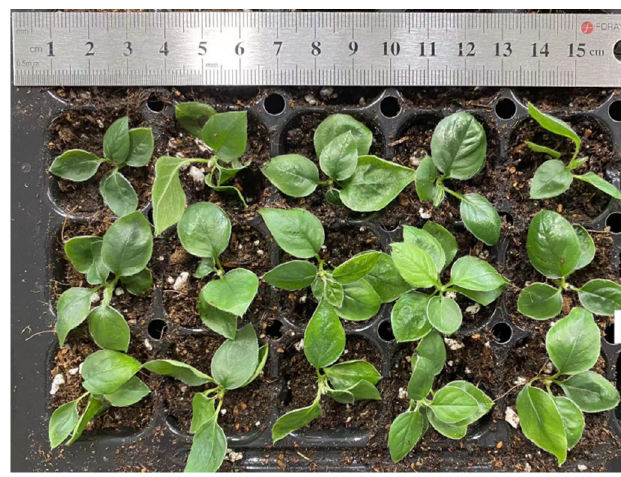
Figure 4. Acclimatized Cotoneaster wilsonii in a glasshouse. Table 3. The effects of auxins on the root induction in Cotoneaster wilsonii